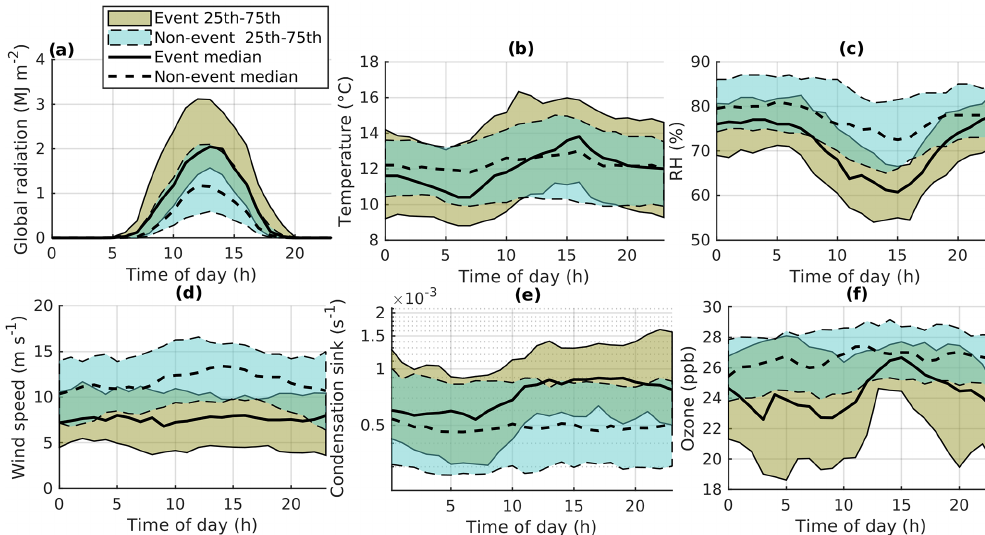
Figure 4. The diurnal cycles of medians and the 25th and 75th percentiles of different meteorological variables, condensation sinks, and ozone during event and non-event